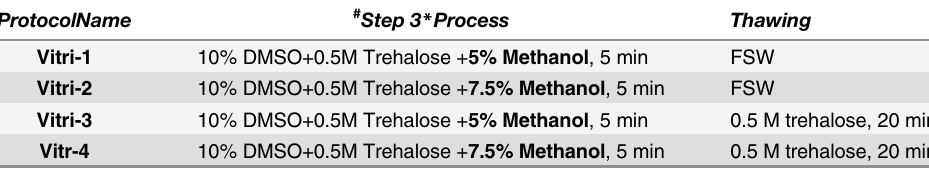
Table 1. Candidate vitrification treatments for Symbiodinium